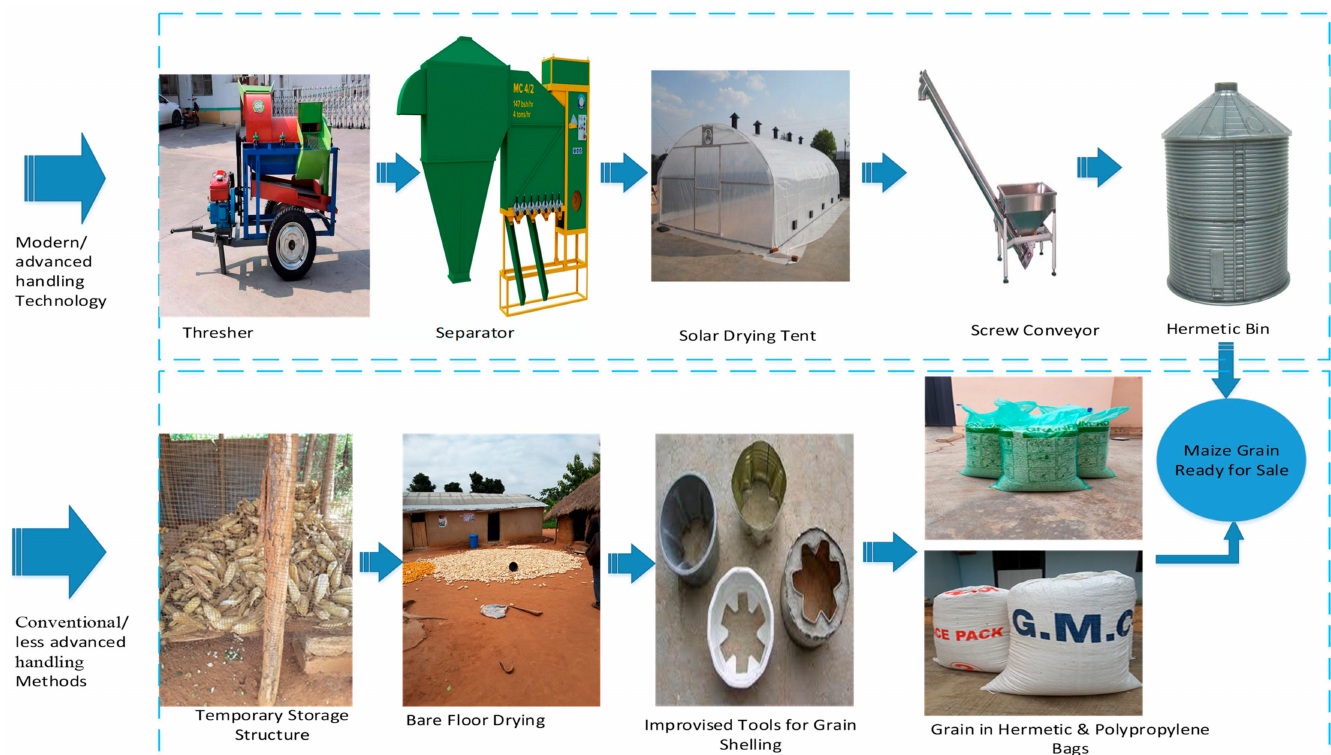
Figure 1. System boundary for the cost analysis of various maize handling